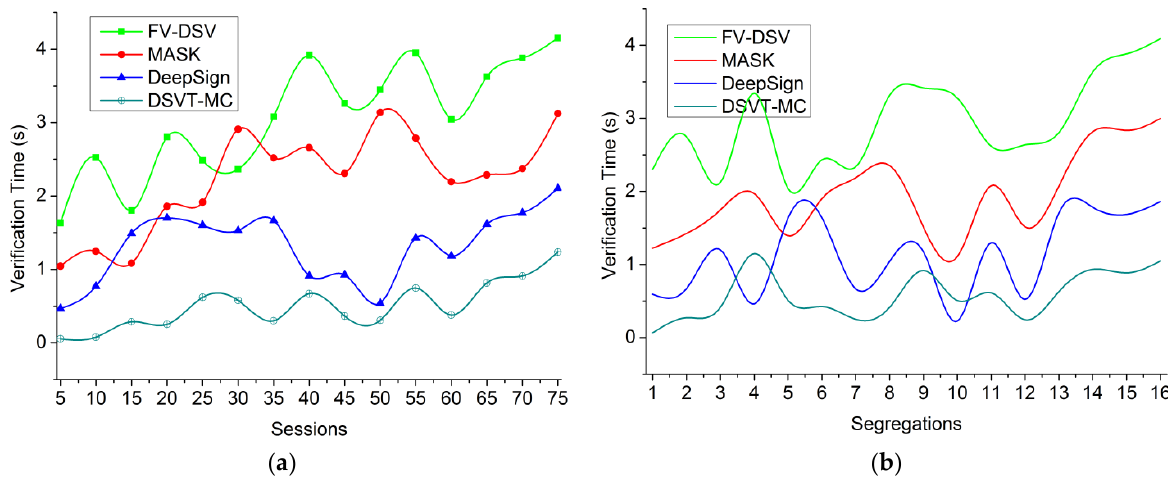
Figure 12. Verification Time for ( a ) different session rate ( b ) Segregation.